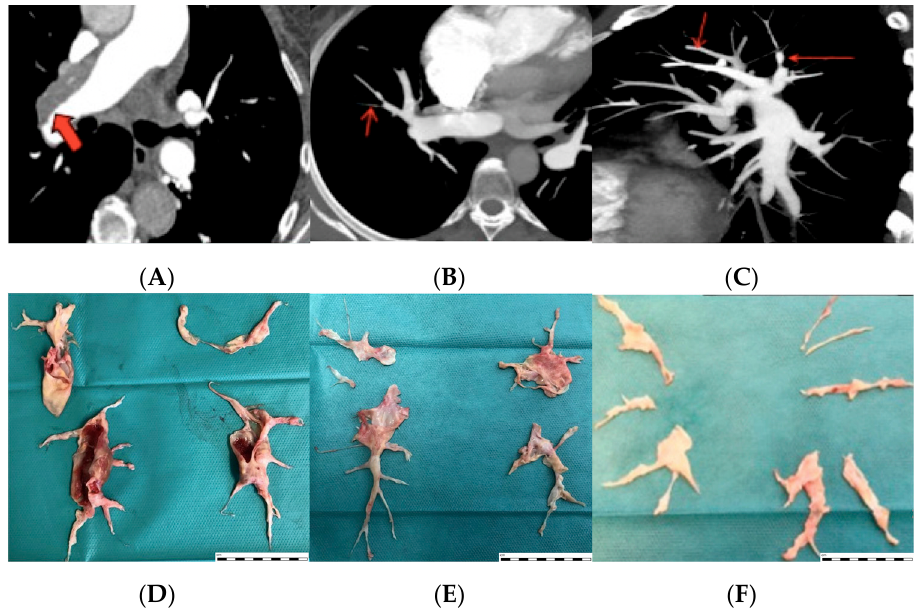
Figure 1. A comparison of angiographic CT images and surgical pieces of pulmonary endarterectomy. In panel ( A ) there is an image of proximal thromboembolic disease in the right pulmonary artery (red thick arrow), more frequent among men. In panels ( B , C ) some images of distal thromboembolic disease are pointed out (red thin arrows), a disease distribution more frequent in women. Panels ( D – F ) show pieces of PEA classified as level I, II, and III after surgery, respectively.